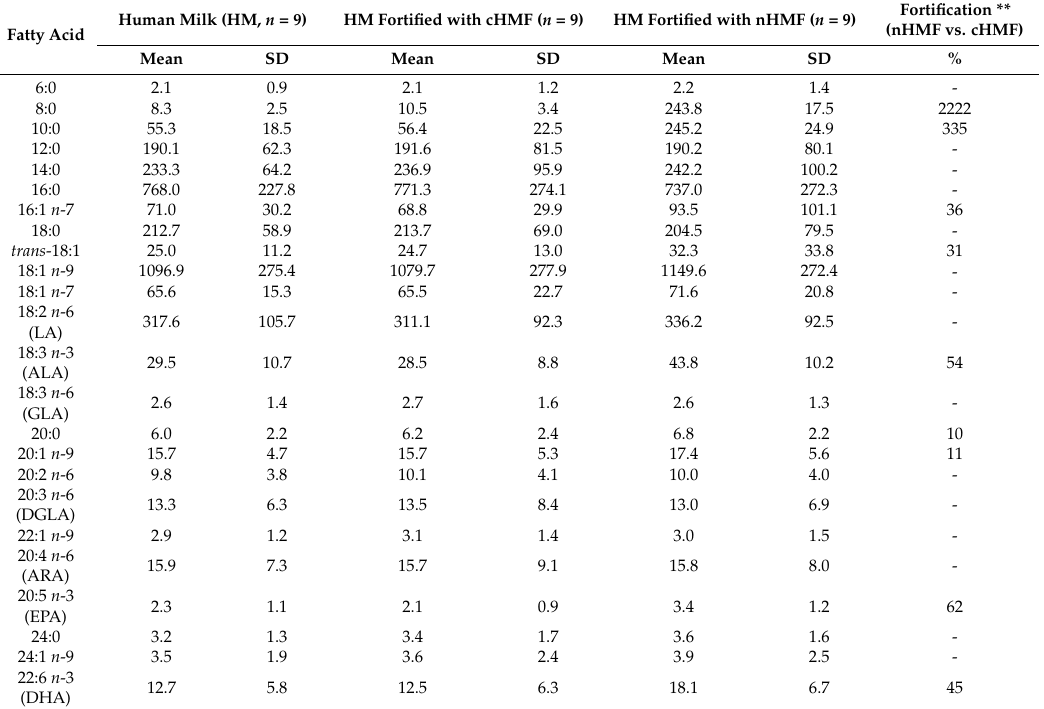
Table 2. Fatty acid content (mg/100 mL) of unfortified human milk * and human milk fortified with a control (cHMF) or a new human milk fortifier (nHMF), and level (%) of fortification achieved with nHMF relative to